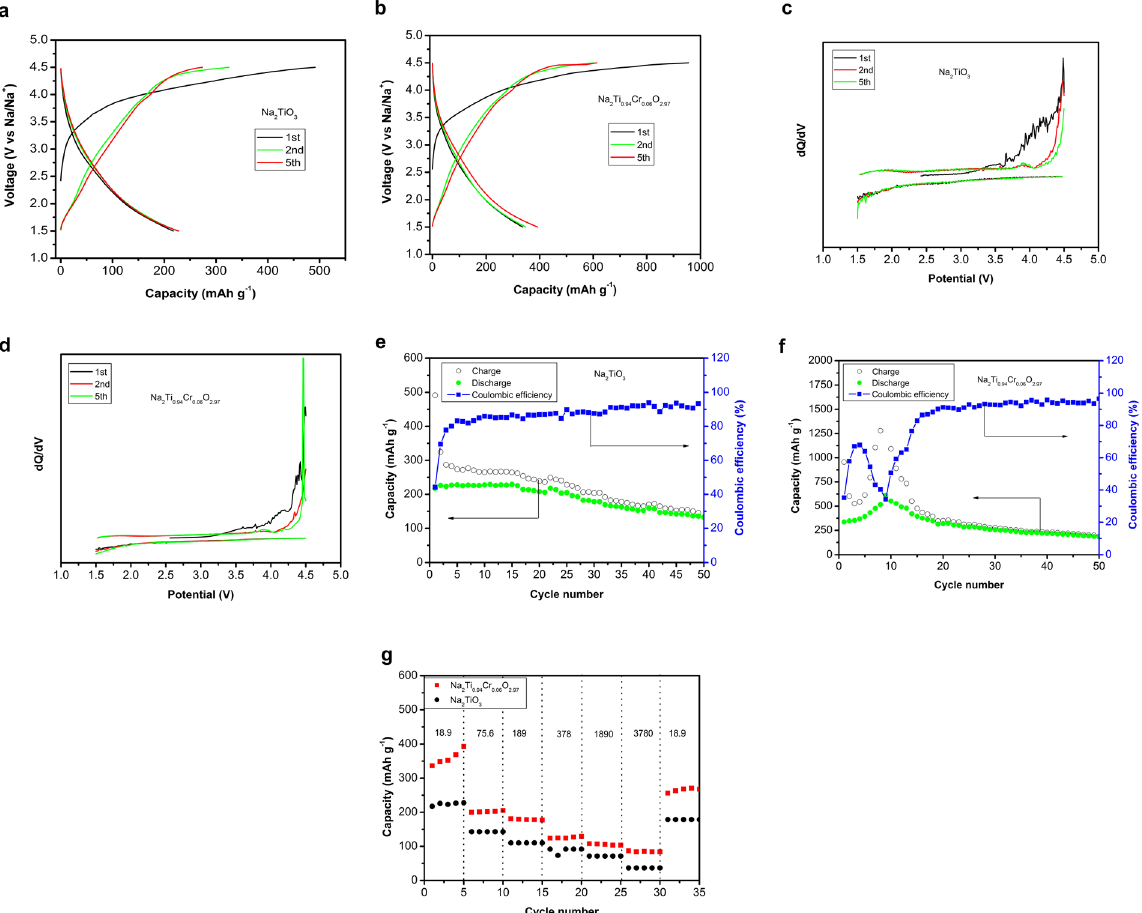
Figure 2. Electrochemical performances of Na 2 TiO 3 and Na 2 Ti 0.94 Cr 0.06 O 2.97 . (a,b) Voltage profiles of Na 2 TiO 3 and Na 2 Ti 0.94 Cr 0.06 O 2.97 . ( c,d) dQ/dV plots of Na 2 TiO 3 and Na 2 Ti 0.94 Cr 0.06 O 2.97 . ( e,f) Cycling performance with Coulombic efficiency of Na 2 TiO 3 and Na 2 Ti 0.94 Cr 0.06 O 2.97 at current density of 18.9 mA g − 1 . ( g) Rate capabilities of Na 2 TiO 3 and Na 2 Ti 0.94 Cr 0.06 O 2.97 at current density from18.9 mA g − 1 to 3780 mA g − 1